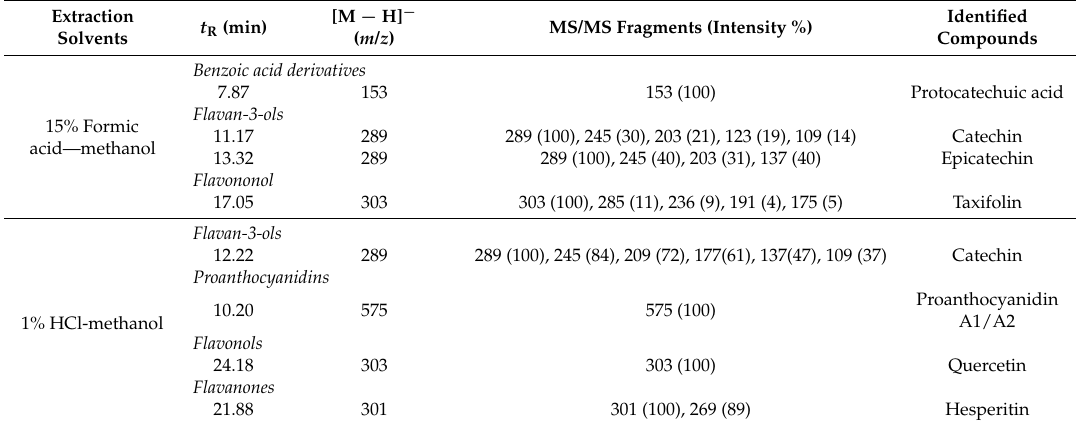
Table 1. Retention time and MS characteristics of phenolic compounds identified in finger millet and